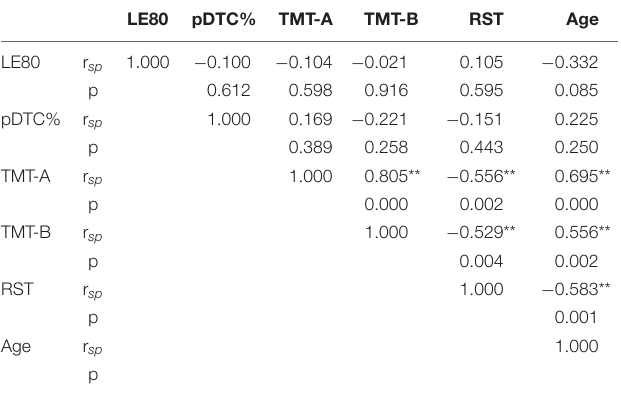
TABLE 3 | Spearman’s rank correlations and significance levels (two-tailed) of the outcome of the listening effort measures (LE80, pDTC%) and neuropsychological tests (TMT-A, TMT-B, RST), as well as age, Asterisk depict significant